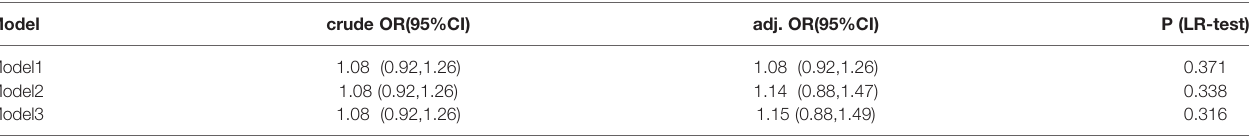
TABLE 2 | Adjusted P value and odd ratio of VD2 and T2DM.